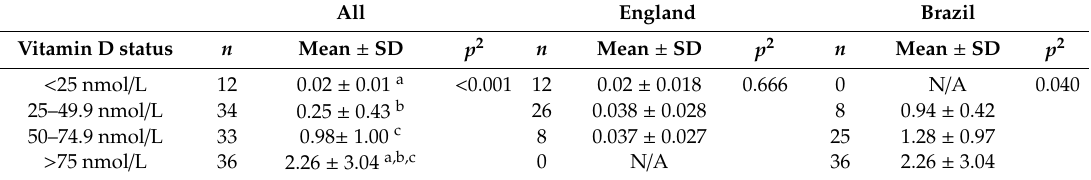
Table 4. Association between Vitamin D status and mean individual UVB radiation level 1 . All England Brazil